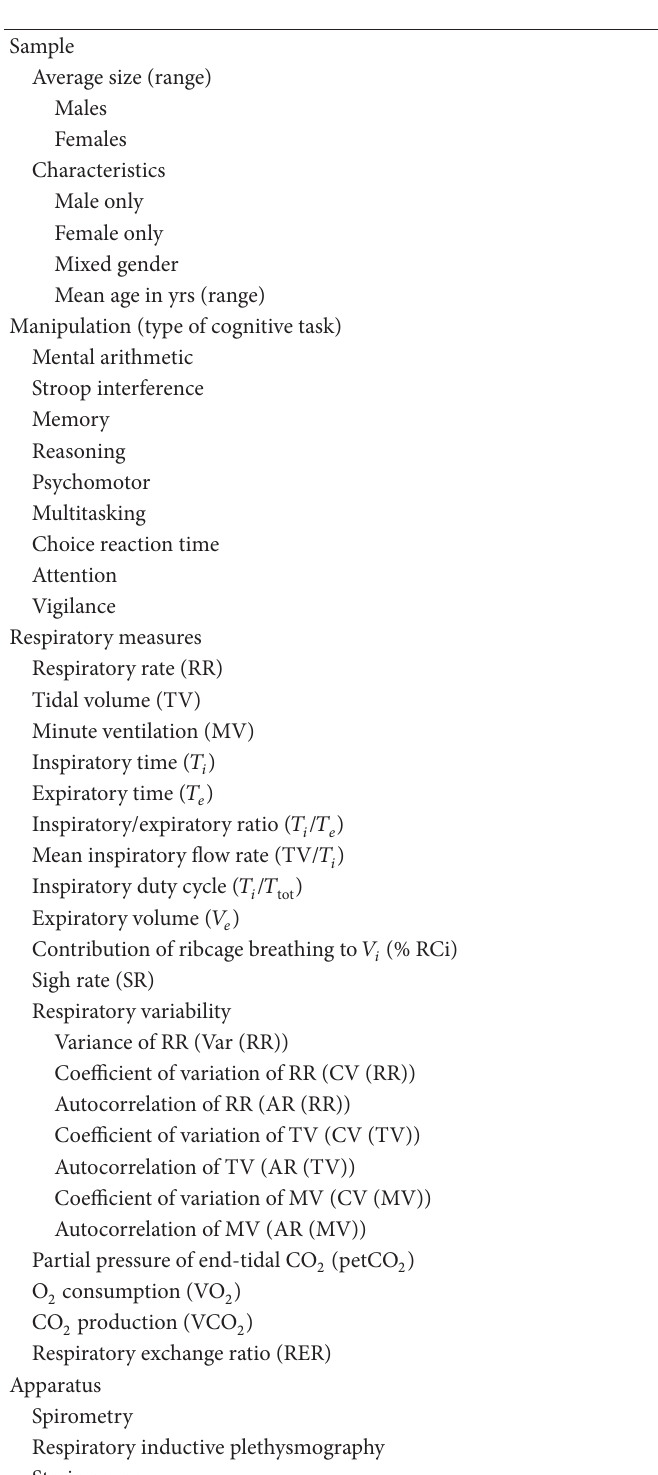
Table 1: Characteristics of selected studies ( 𝑁 = 54